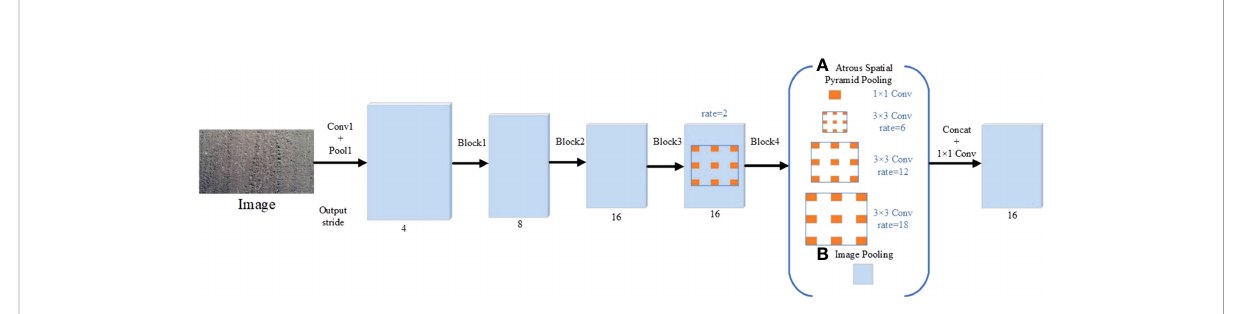
FIGURE 6 Schematic diagram of the DeepLabv3 structure. (A) Atrous Spatial Pyramid Pooling; (B) Image